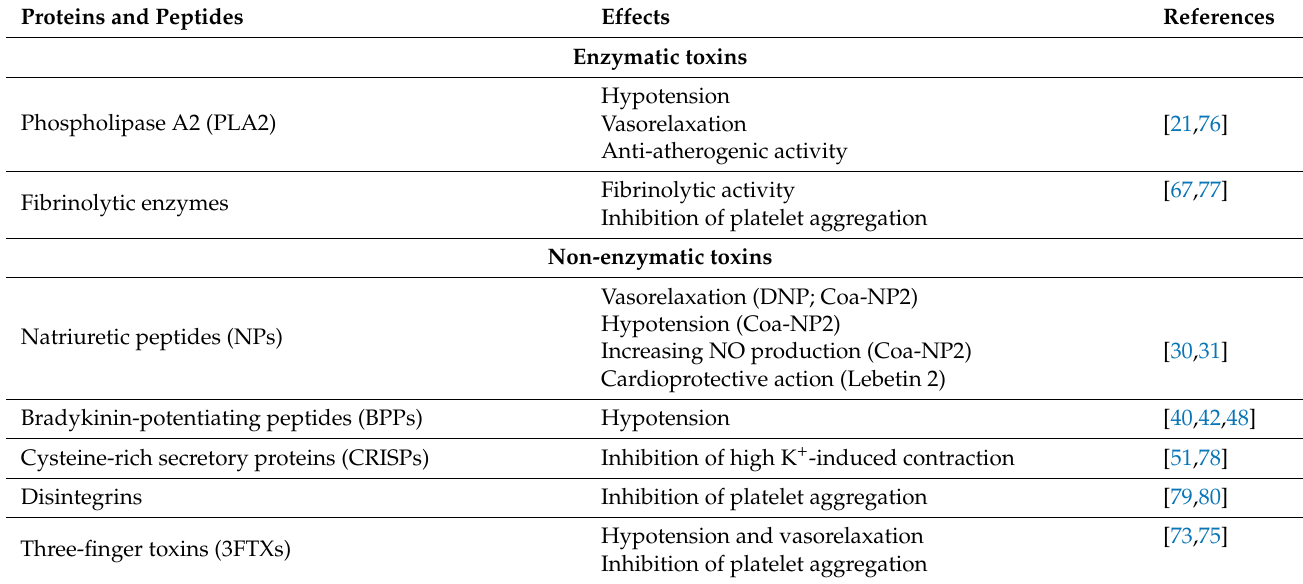
Table 1. Summary of snake venom components and their effects on the cardiovascular